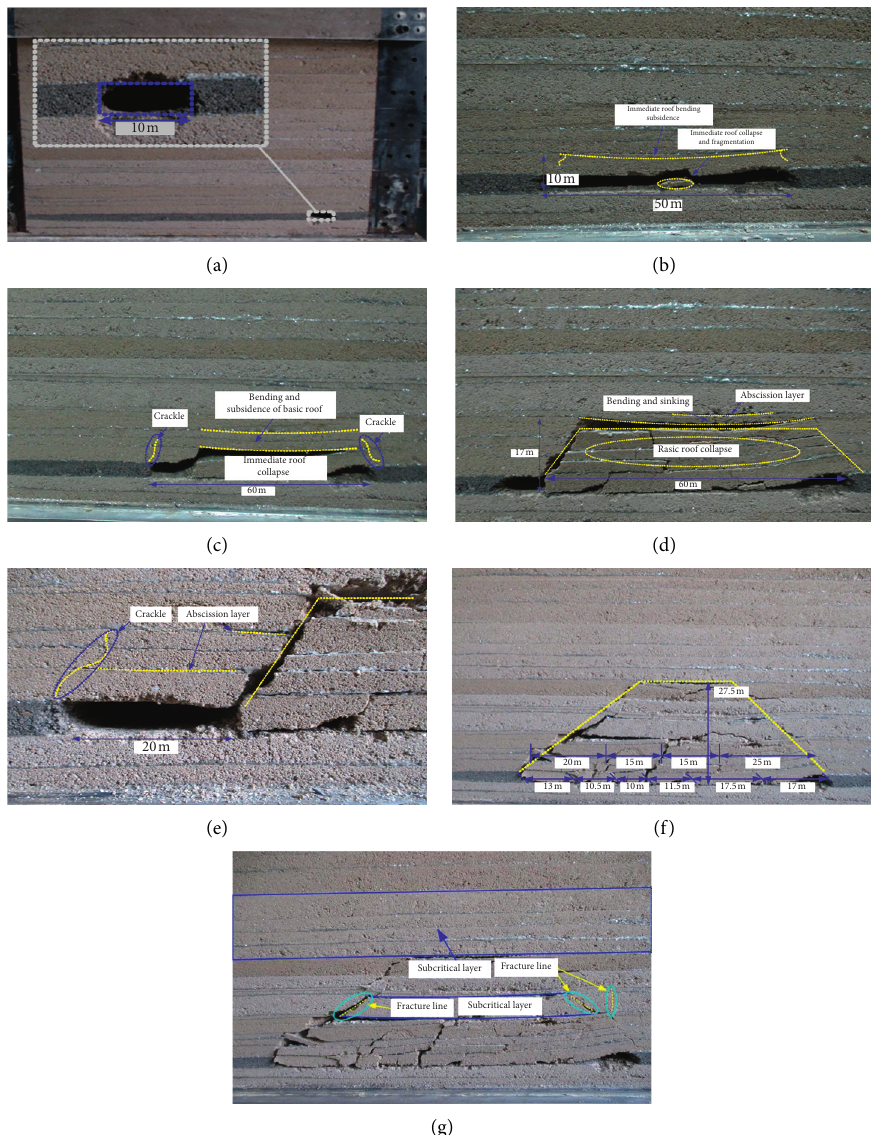
Figure 5: Overlying strata movement in seam mining. (a) Working face advancing 10 m.(b) Working face advancing 50 m. (c) Working face advancing 60 m. (d) Working face advancing 70 m. (e) Working face advancing 80m. (f) Stability of overlying strata after working face advancing for 80 m. (g) Schematic diagram of the key layer above working